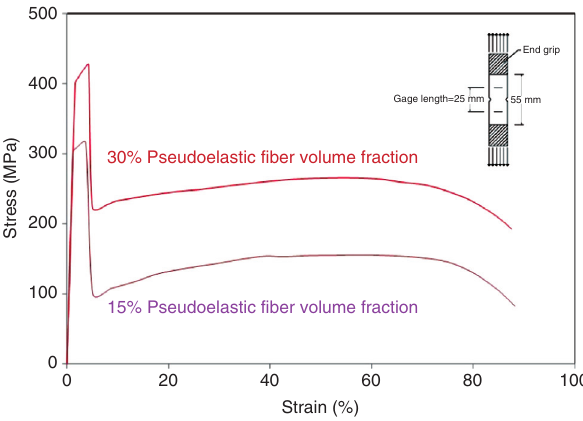
Figure 8 Effect of fiber volume fraction on tensile stress-strain behavior of pseudoelastic fiber-reinforced aluminum matrix composites.